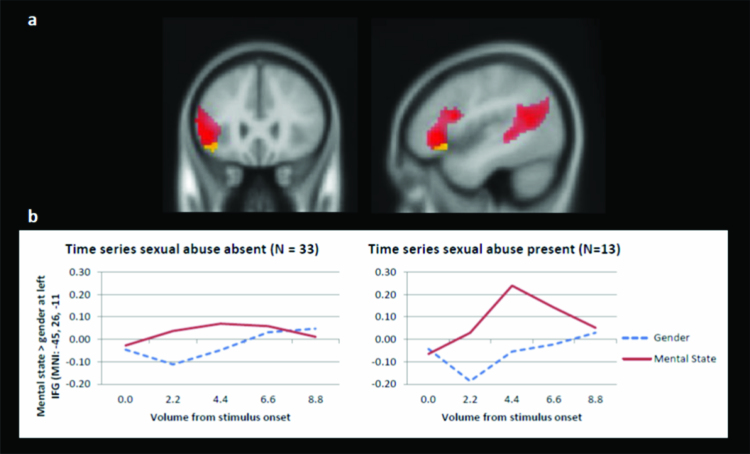
a: Positive relation between SA and left IFG (MNI: −45, 26, 11) resulting from a regression analysis with all subscales (Yellow, FWE cluster extent threshold with p < .001) depicted on whole brain mental state > gender contrast (Red, FWE cluster extent with p < .001). b: Time series of gender and mental state contrast represent the mean activation of the active cluster in the left IFG (MNI: −45, 26, −11) for five volumes (TR = 2.2 s) starting at stimulus onset to four volumes after. The time series covers one trial (8000 ms) and the onset of the next trial (800 ms).